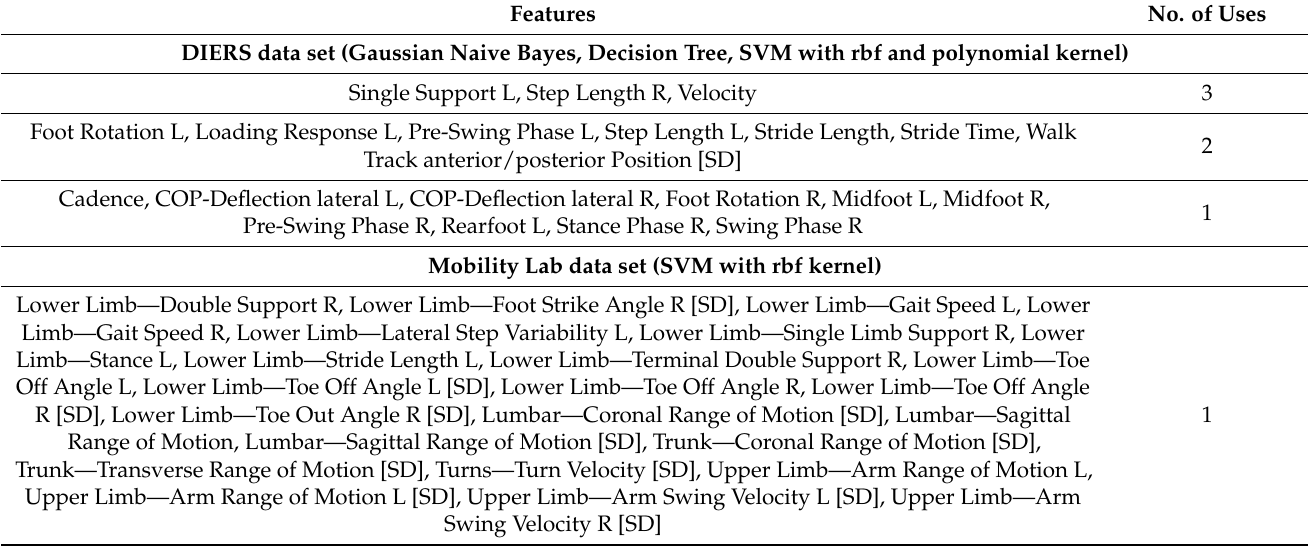
Table 6. List of features for classification models with moderate agreement for each data set (matched collective). The gait parameters are given in their mean value. If the standard deviation of the gait parameter is meant, it is explicitly followed by [SD]. Features No. of Uses